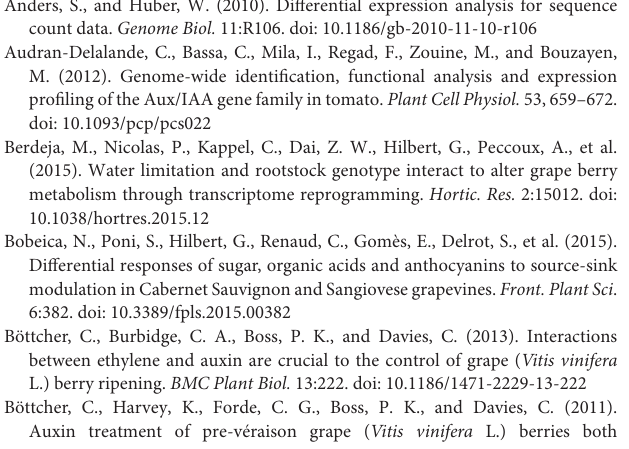
performed in flesh and skin of berries sampled from both 1103P/CS (solid bars) and M4/CS (empty bars) graft combination in 2011 growing season. Results are shown as means and SE for two biological replicates. Bars indicate SE. Different letters indicate statistically significant differences ( P = 0.05 ) by Duncan’s new multiple range test. Supplementary Figure S4 | Quantitative RT-PCR analyses on the following flavonoid-related genes: VviPAL3 -like (VIT_13s0019g04460, A), VviCHS3 (VIT_05s0136g00260, B), VviLAR2 (VIT_17s0000g04150, C), VviFLS1 (VIT_18s0001g03430, D), and VviUFGT (VIT_16s0039g02230, E). Transcript levels in CS/1103P (black) and CS/M4 (white) berries are shown as means of normalized expression ± SD. Supplementary Results S1 | Nomenclature of genes belonging to the grapevine ARF, Aux/IAA, and GH3 multigenic families. Supplementary Table S1 | Primers used for qPCR analyses. V1 12X identifier (V1 12X ID), gene name, forward (FW sequence) and reverse (RV sequence) sequences are reported. Supplementary Table S2 | (A) Sequencing and alignment statistics. Sample name (Sample), replicate, paired-end Tag, total number of produced reads (Total), filtered reads after trimming (Filtered), good-quality reads (# Good), aligned and percentage of aligned reads (% Aligned), number of alignment (# alignment) are reported. (B) Summary of read number after pairing (F3 + F5). Sample name (Sample), library name (LibName), number of unique reads after pairing (Single), percentage of sequences that aligned on a gene (% ReadsOnGene), number of gene with at least five reads (# of genes) and percentage of genes with at least five reads (% of genes). Supplementary Table S3 | List of DEGs influenced by Rootstock (R), Tissue (T), and Phenological Phase (PP) components. Numbers of DEG are given in brackets. PN40024V1 12X annotation (V1 12X ID) and functional annotation (Funct. annot.) of DEGs are reported. Statistical analysis were carried out according to an FDR adjusted p -value lower than 0.05. Supplementary Table S4 | Over-enriched GO terms of genes differentially expressed influenced by rootstock (R), tissue (T), and phenological phase (P) factors. For each term, the GO identifier (GO-ID), the complete Gene Ontology term (Description), the p -value and the FDR-corrected P -value (corr p -value) of the Fisher’s exact test, the numbers of sequences in the test set (x) are provided. Supplementary Table S5 | Expression values (mean normalized mRNA-seq counts) of all 56 auxin-related genes. Gene family, V1 12X annotation, gene name are reported. Graft combination (CS/1103P and CS/M4), considered tissue (whole berry, skin, and pulp) and phenological phase (E-L31, E-L36, and E-L38) are also